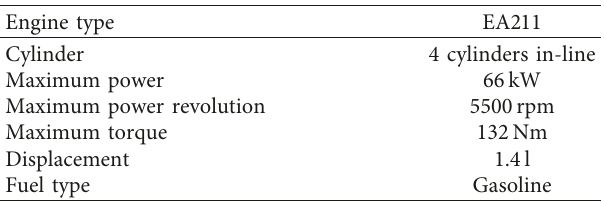
Figure 13: Experimental stand of the engine. (1) Sensor power supply; (2) data acquisition card; (3) computer; (4) acoustic sensor; (5) encoder fixing device; (6) encoder; (7) coupling; (8) connecting device; (9) engine. Table 2: Gasoline engine